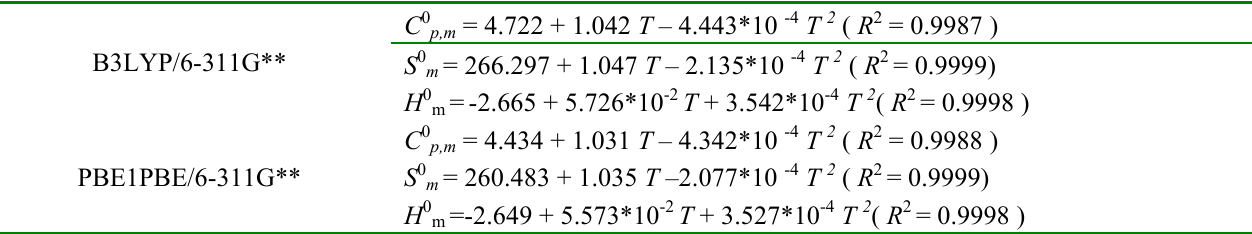
Table 6 .The correlation equations between thermodynamic properties and temperature. B3LYP/6-311G**